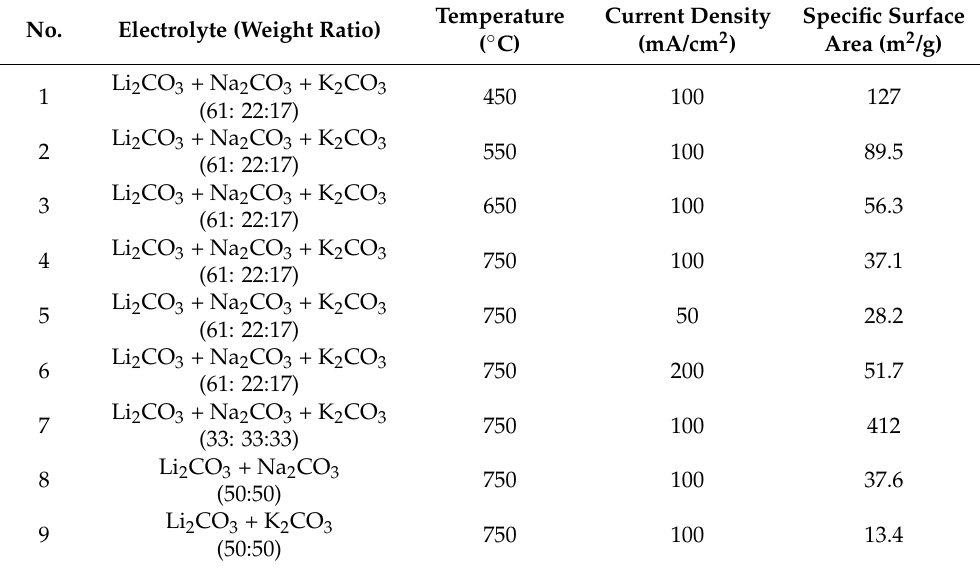
Table 1. The specific surface area of amorphous carbon with different electrolysis parameters.